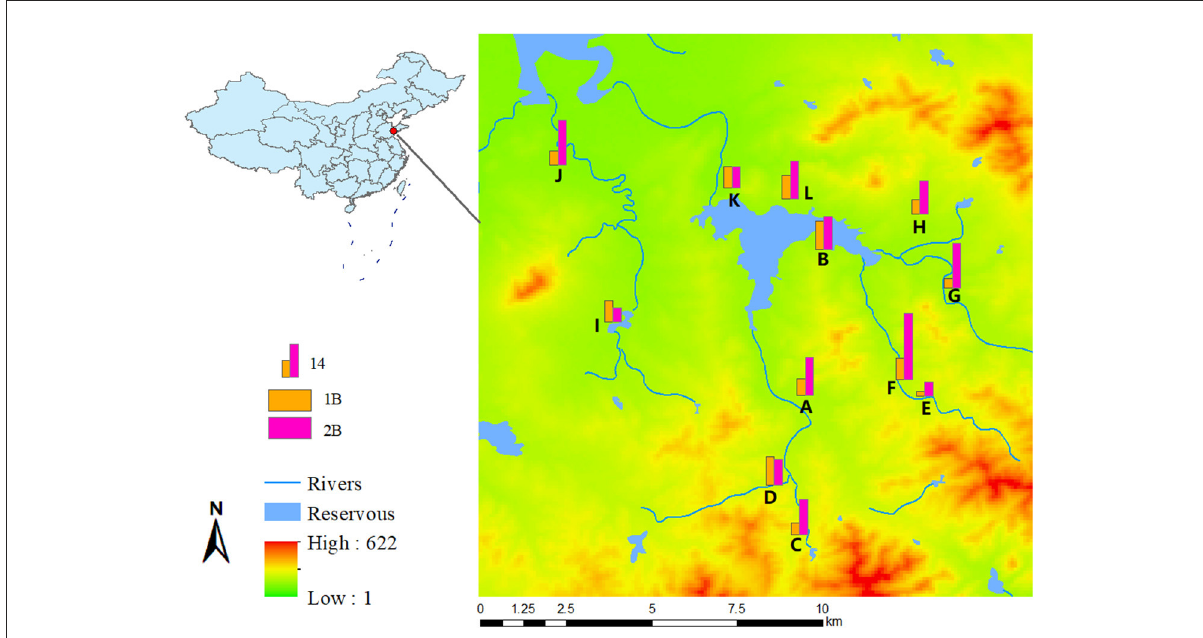
FIGURE1 Geographic distribution map of ESBLs-producing K. pneumoniae from village A to L, in 2015 and 2017, with digital elevation